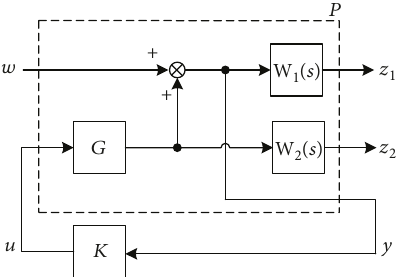
Figure 10: Black diagram of the S / T problem.